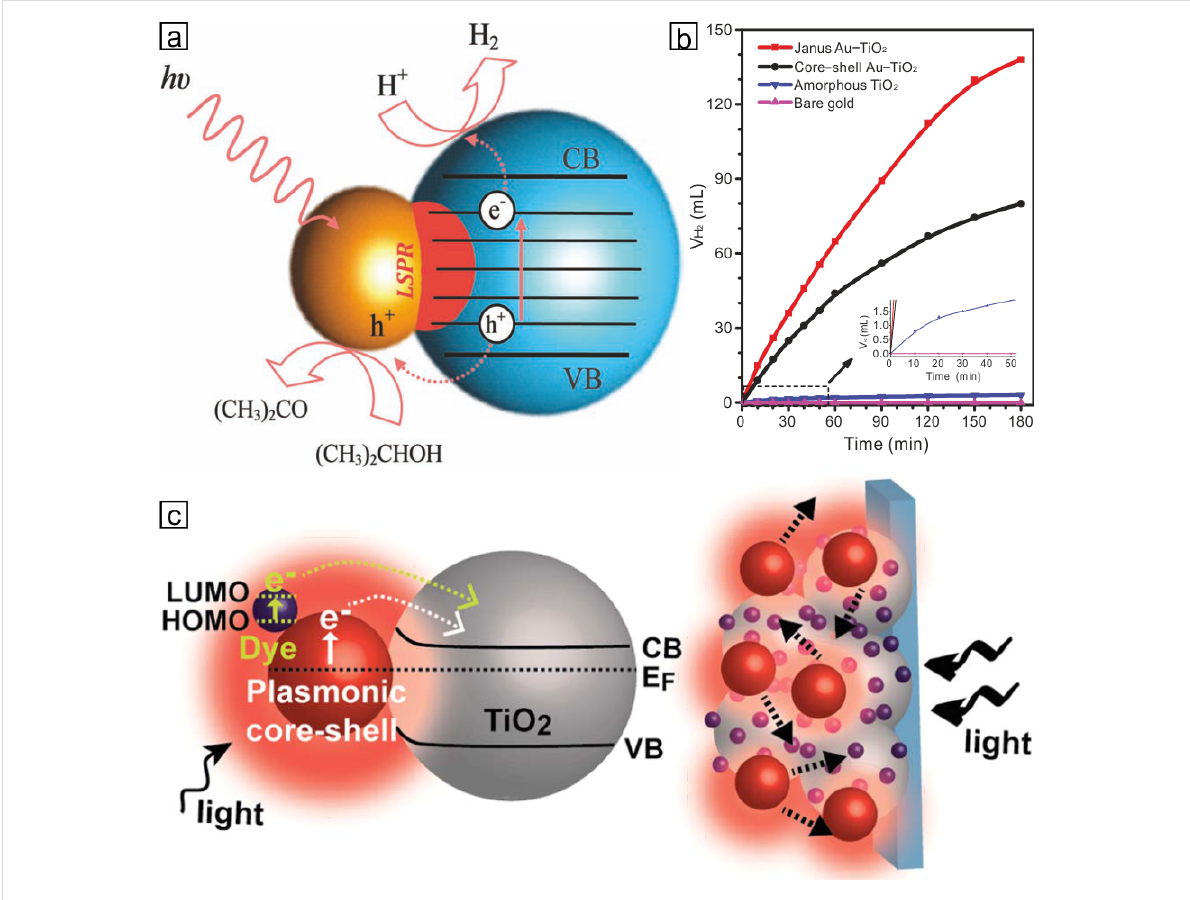
Figure 6: a) Proposed photocatalytic process for efficient hydrogen generation using the Janus Au@TiO 2 nanostructures, based on excitation of the LSPR under visible-light irradiation [50]. b) Volume of hydrogen generated ( V H2 ) under visible-light irradiation from a tungsten halogen lamp using Janus and core-shell Au 50nm @TiO 2 nanostructures, as well as amorphous TiO 2 and bare gold particles [50]. c) Schematic illustration of plasmonic dye-sensitized solar cells (DSSCs) with tailor-designed Au–TiO 2 nanostructures integrated into the photoanode representing the increased photocur- rent by LSPR and scattering effects [51]. (a, b) Adapted with permission from [50]. Copyright 2012 WILEY-VCH. (c, d) Reproduced with permission from [51]. Copyright 2014 The Royal Society of